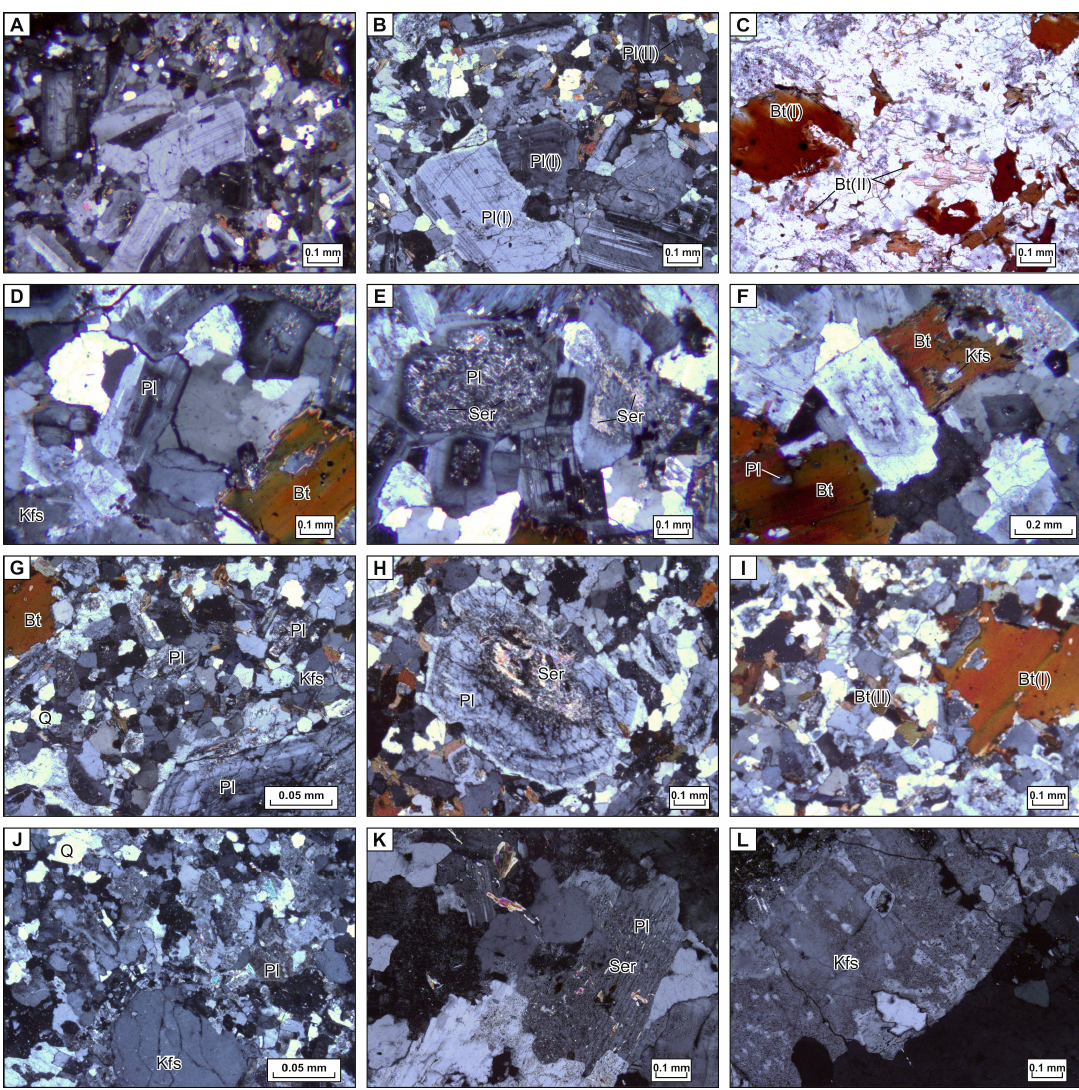
Figure 4. Photomicrographs of igneous rocks of the Sokh massif, x ‐ nicols: ( A ) general texture of granodiorite (sample 1183); ( B ) simple twins of plagioclase of first ‐ generation Pl(I) and second ‐ generation Pl(II) (sample 1183); ( C ) biotite of two generations: first (Bt(I)), second (Bt(II)) (sample 1183); ( D ) general texture of adamellite (sample 1174); ( E ) sericitized plagioclase (sample 1174); ( F ) biotite with inclusions of plagioclase and K ‐ feldspar (sample 1174); ( G ) hypidiomorphic granular texture of granite (sample 1176/1A); ( H ) zonal sericitized plagioclase (sample 1176/1A); ( I ) biotite of two generations: first (Bt(I)), second (Bt(II)) (sample 1176/1A); ( J ) general texture of aplite, porphyric grains of K ‐ feldspar of xenogenic nature (sample 1177/8); ( K ) rare sericite in plagioclase (sample 1177/8); ( L ) perthites in K ‐ feldspar (sample 1177/8).